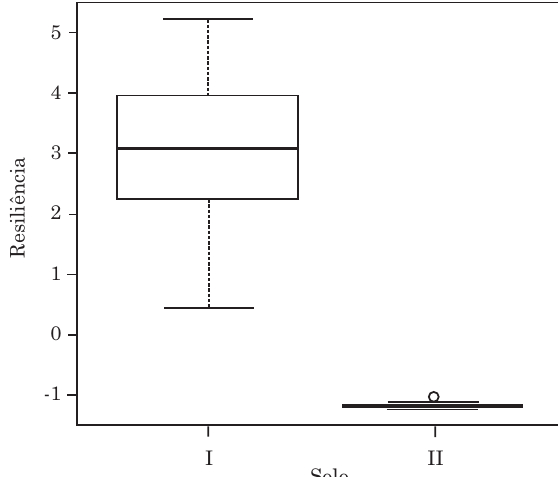
Figura 4. Distribuição dos índices de resiliência do conteúdo volumétrico de água de dois Latossolos Vermelhos distróficos, um argiloso (I) e um franco-argilo-arenoso (II). As barras representam o intervalo de confiança da média (85 %).